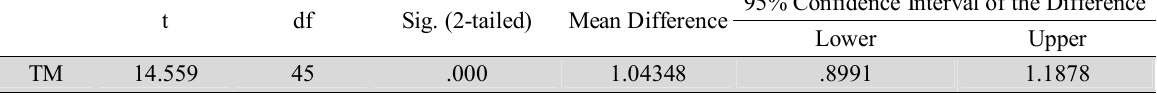
The summary of testing the effect of information technology on technology management (Test value = 3) 95% Confidence Interval of the Difference t df Sig. (2-tailed) Mean Difference